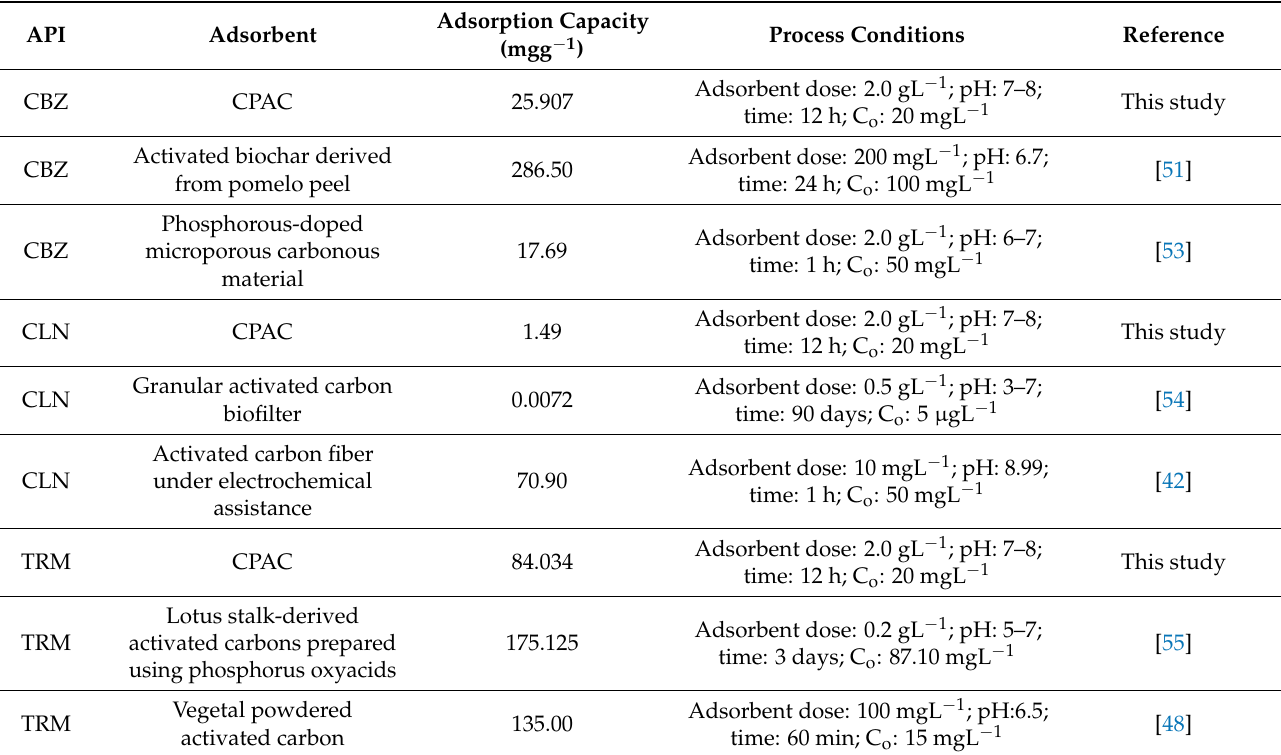
Table 6. Maximum adsorption capacities from this study compared with other carbonaceous